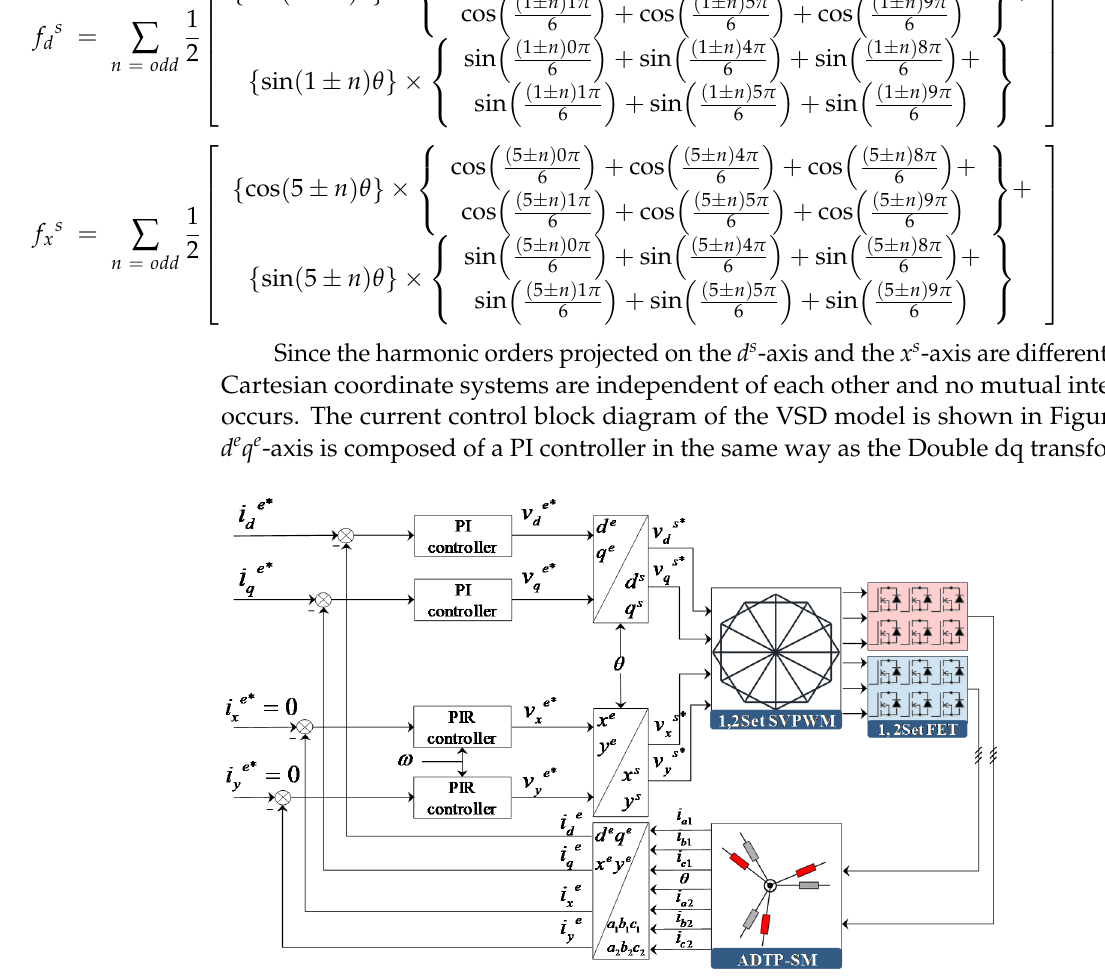
Figure 3. Current control block diagram applying the vector space decomposition (VSD) model of ADTP-SM.